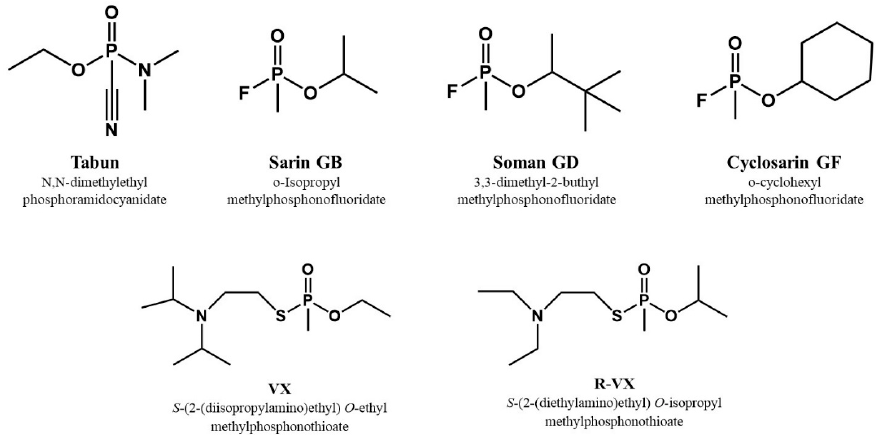
Figure 1. Nerve agents of G (top) and V (bottom) series.